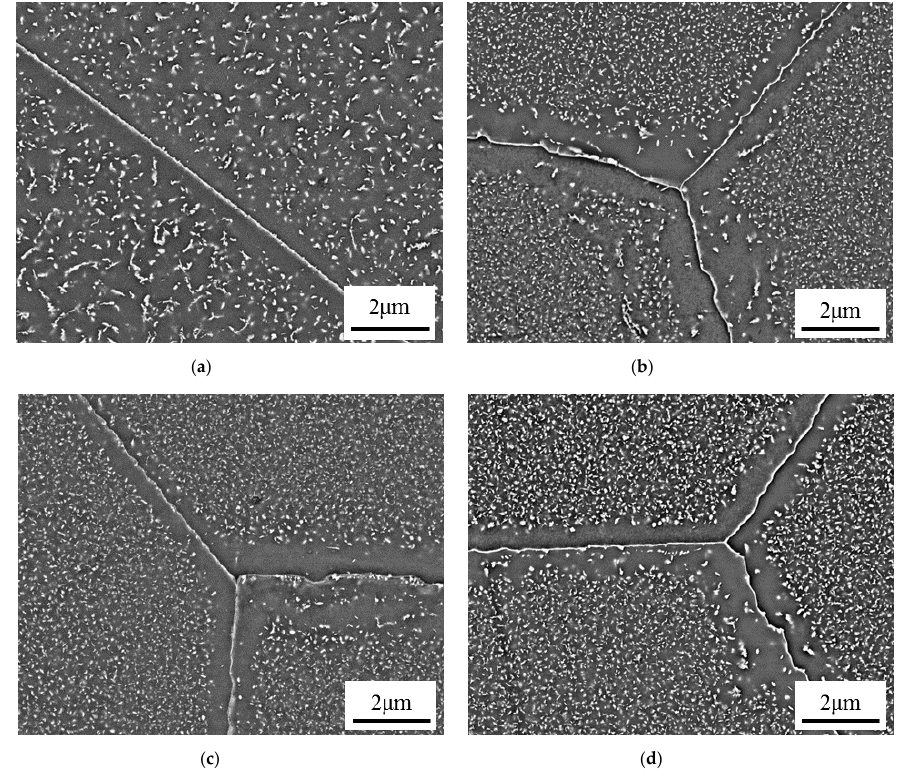
Figure 2. Microstructures of the precipitation-treated steels: ( a ) 17Cr2 (2.4W0.6Nb) base alloy; ( b ) 2.6W1Nb; ( c ) 3.1W1Nb; and ( d ) 4W1Nb (SA + 650 °C/10 h).